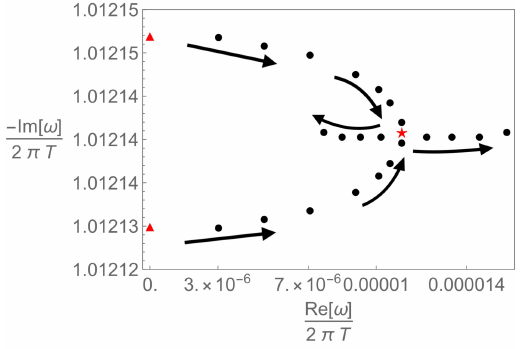
Figure 3 . Quasi-normal modes in the complex ω plane as φ k is increased from 0 (red triangles) to 0 . 0000116 at H/T 2 = 10 5 and | k | /T = 46 . 342712 . Red triangles are the same as in figure 2(b). Red star indicates the collision point ( φ 0 . 00001113 ). k ∼